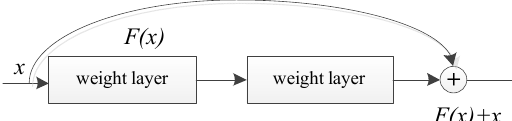
Figure 1. Residual